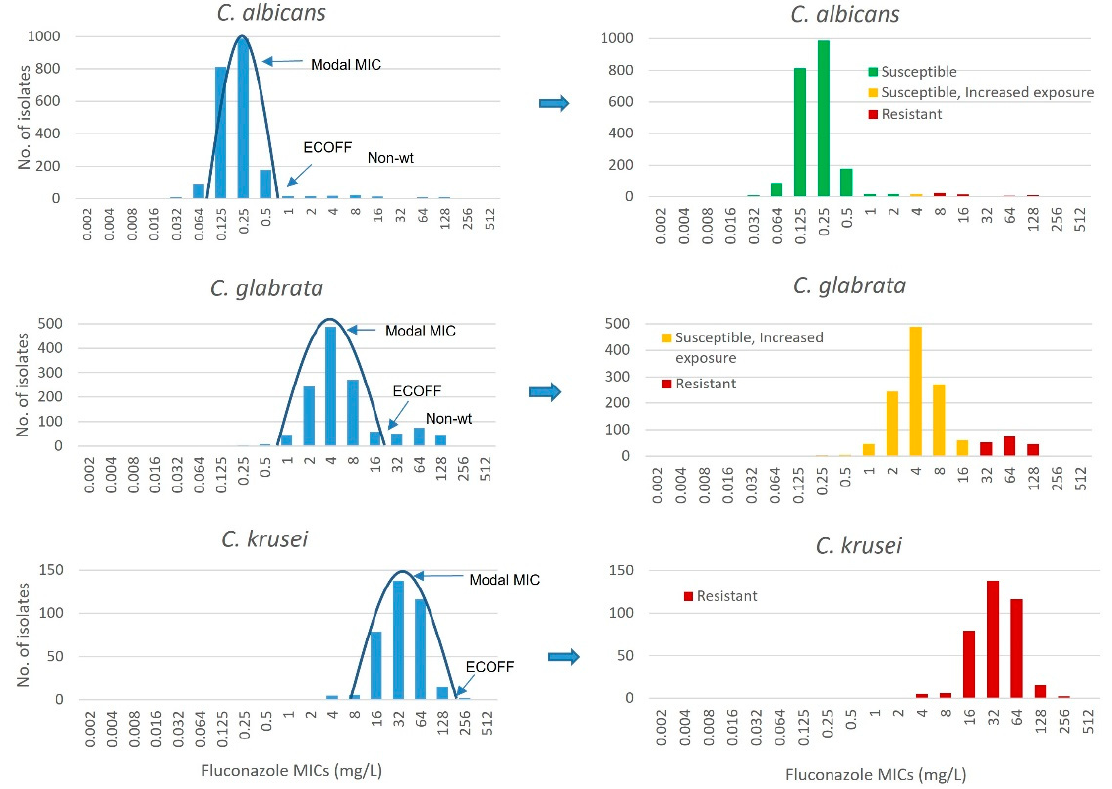
Figure 1. MIC distributions with applied ECOFFs, clinical breakpoints, and susceptibility classifications for three common Candida species. MIC distributions, ECOFFs, and clinical breakpoints are based on the EUCAST document “Fluconazole: Rationale for the clinical breakpoints,” version 3.0, 2020. http://www.eucast.org (accessed on 9 December 2021).